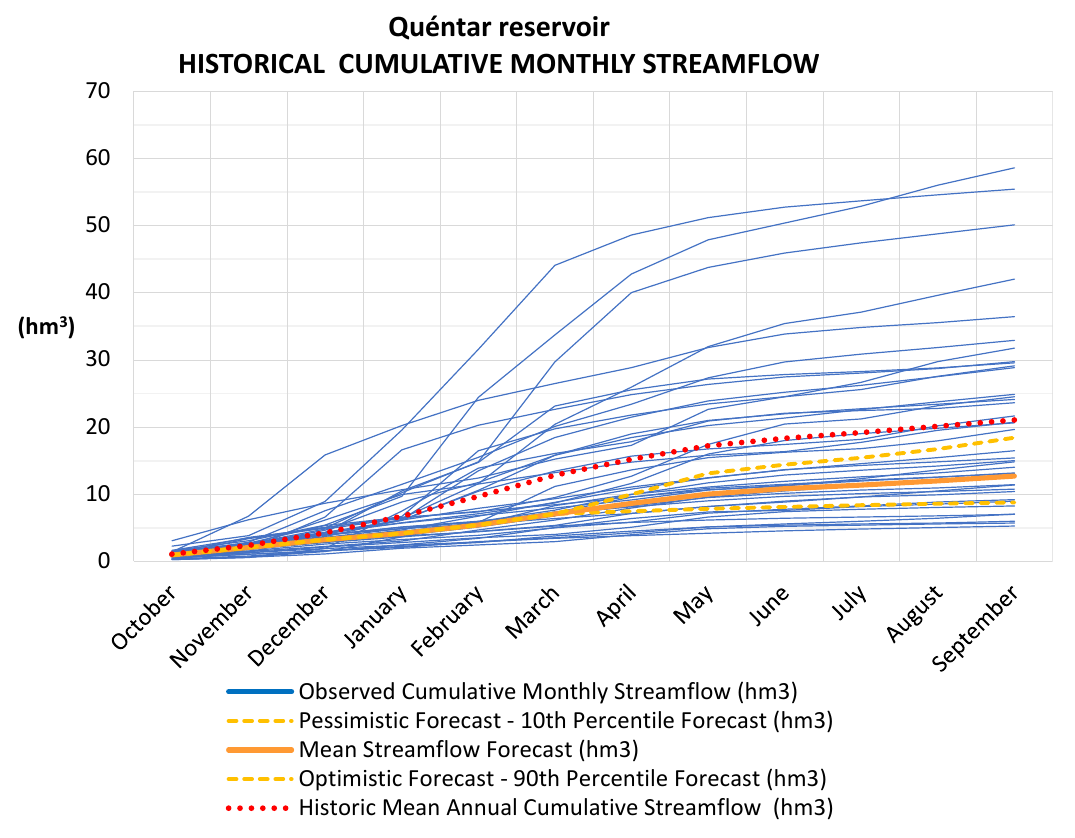
forecast output while the yellow dotted lines are the 90th and 10th percentiles forecasts (optimistic and pessimistic, respectively).